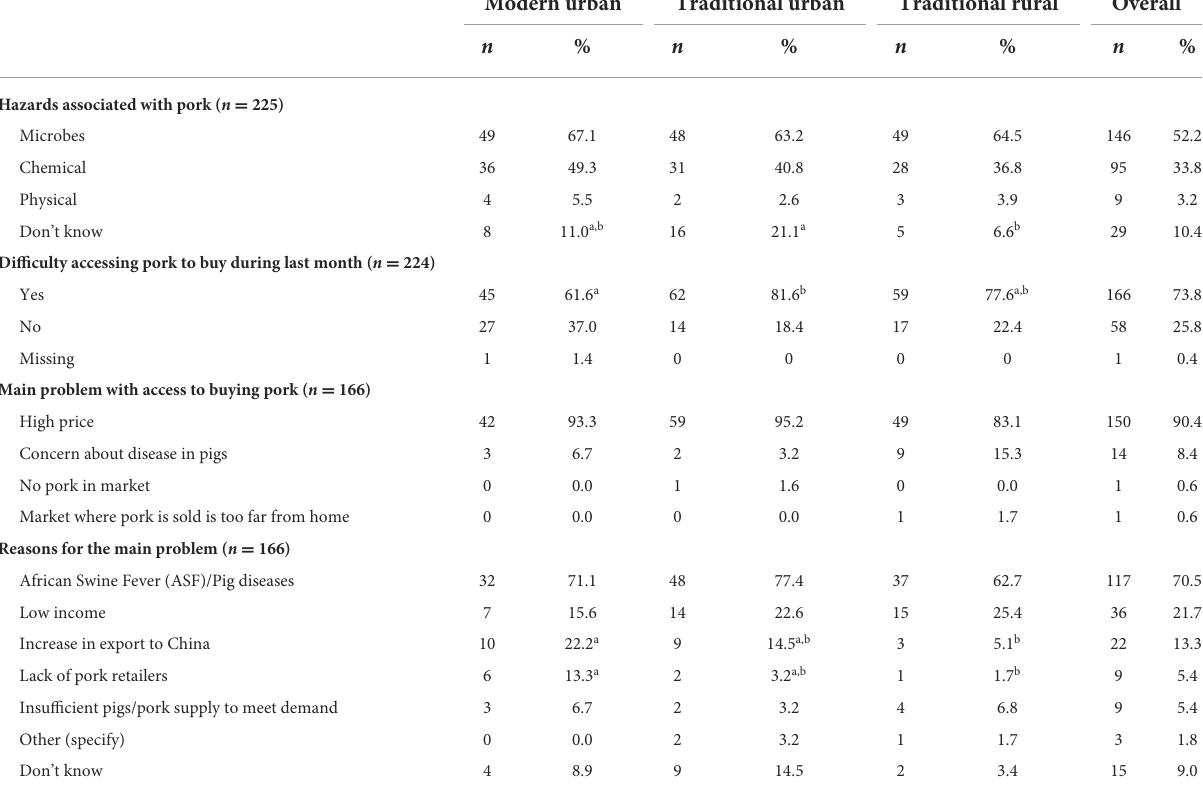
TABLE 2 Perception of hazards associated with pork, main problems with access to buying pork and its reasons reported by pork consumers at three retail types in Northern Vietnam in